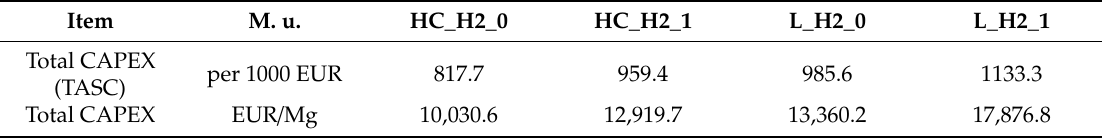
Table 3. Total CAPEX for analyzed